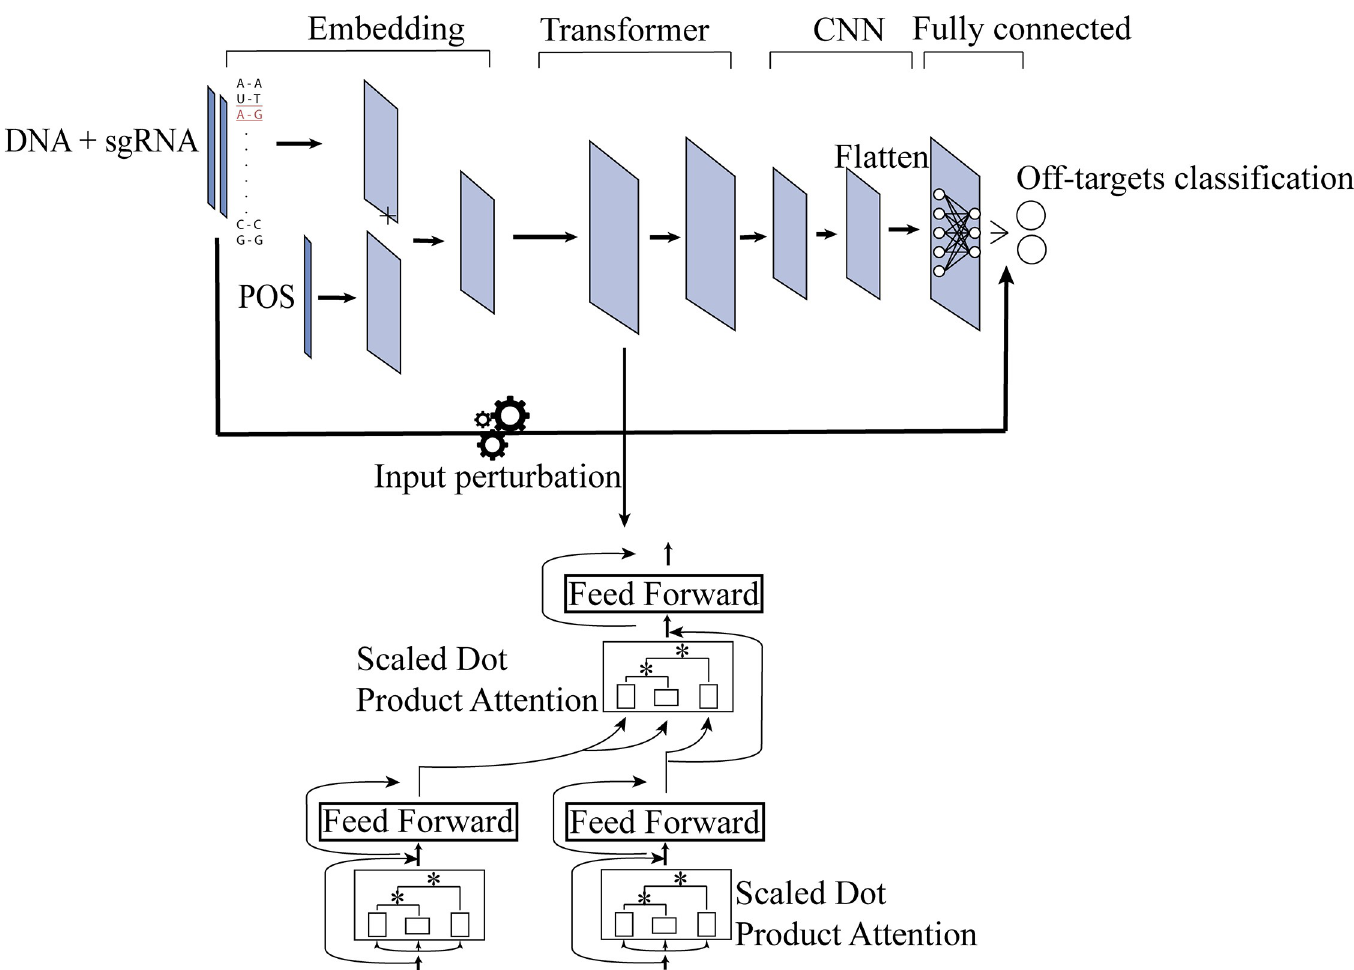
Fig 1. Schematic representation of the off-target specificity prediction model, AttnToMismatch_CNN.